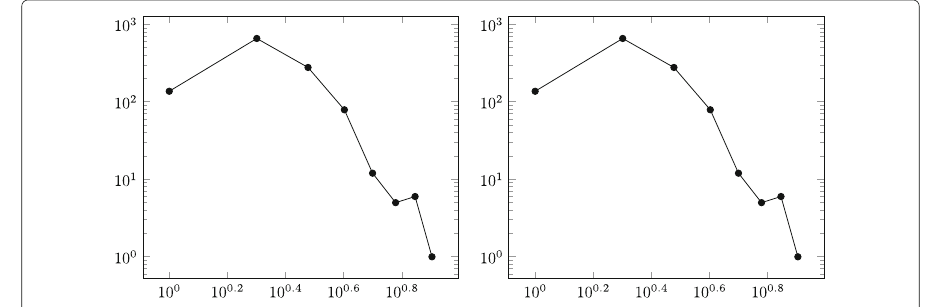
Fig. 11 Head size distribution of M (left) and S